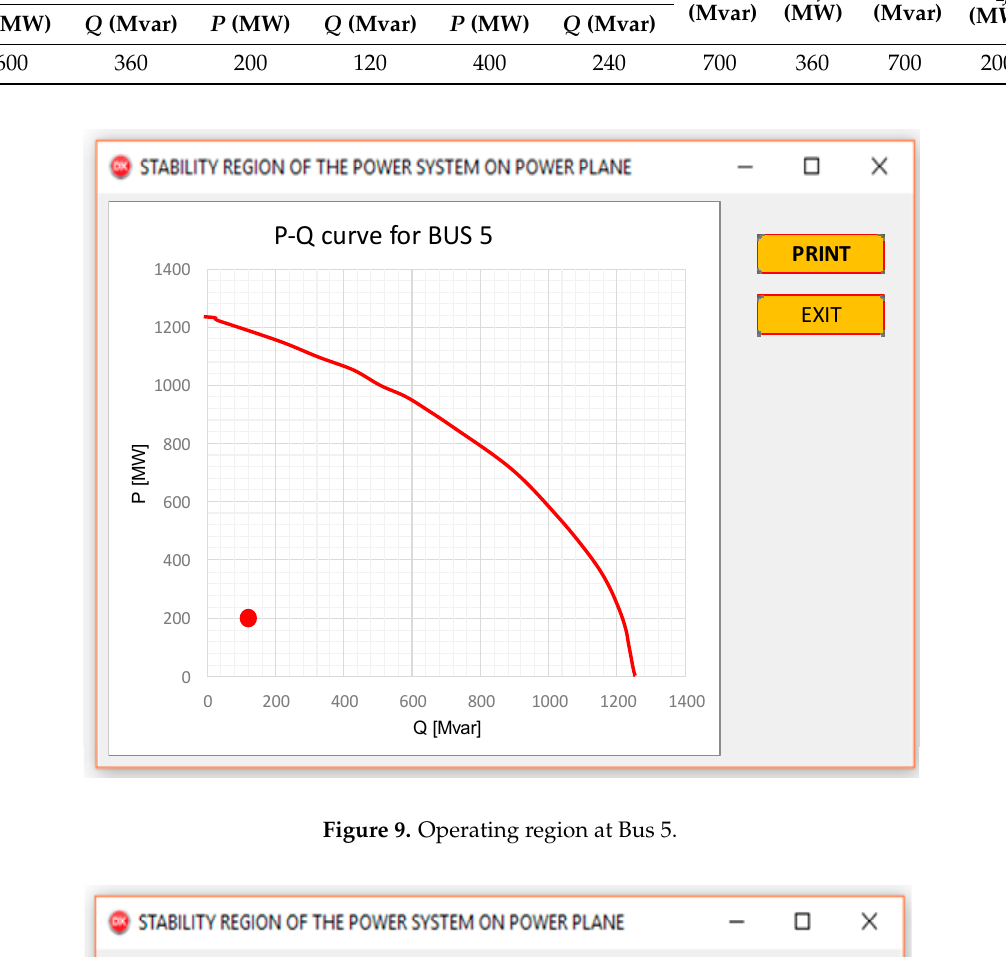
Table 1. Operating parameters for the six-bus test system.